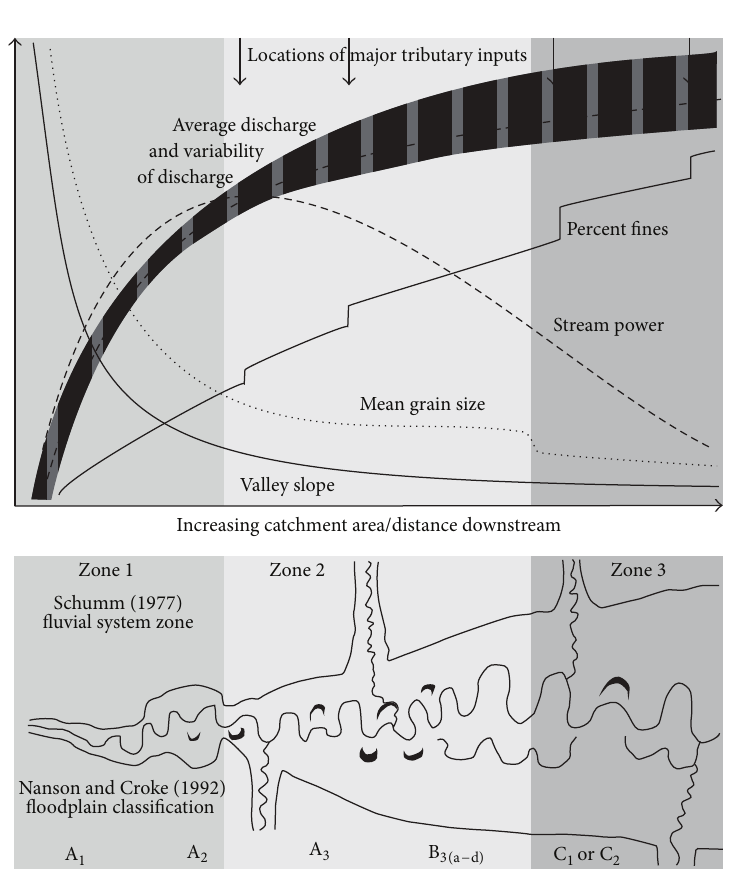
Figure 1: Longitudinal profile and downstream changes for an idealized catchment. The upper panel shows the downstream changes in slope, discharge, discharge variability, grain size, percentage of fines, and stream power expected in a catchment with a typical exponential long profile and a regular pattern of downstream tributary inputs. The lower panel shows the expected pattern of decreasing confinement in a downstream direction, with increasing meander wavelength, and a midcatchment peak in meander migration rates (and cutoff formation). The three zones correspond to the Schumm erosion, transport, and deposition zones [36]. The approximate locations of floodplain types according to the Nanson and Croke classification are also shown